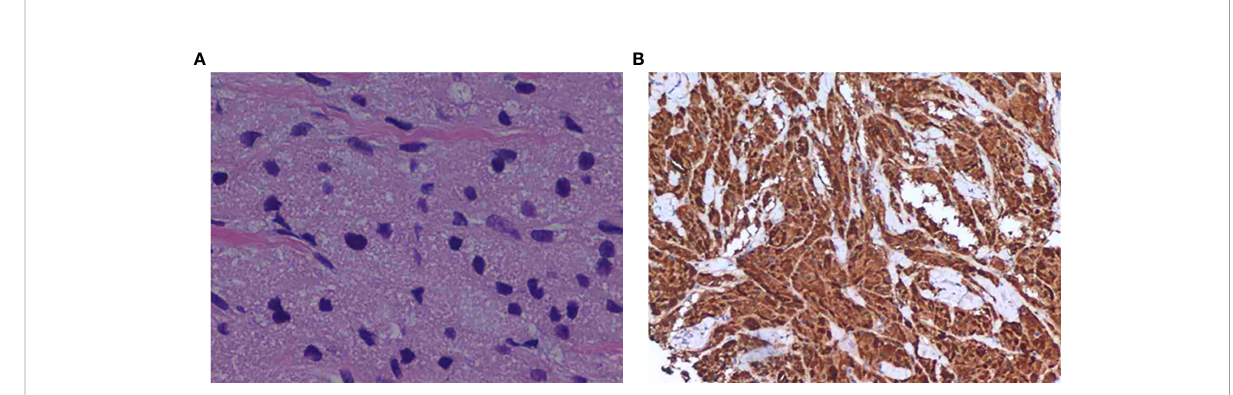
FIGURE 3 (A) Solid nests of tumor cells with coarsely granular cytoplasm. (hematoxylin-eosin, original magni fi cation ×200). (B) Staining was positive for the S-100 protein, as shown by brown granules in the cytoplasm of the tumor cells (original magni fi cation,